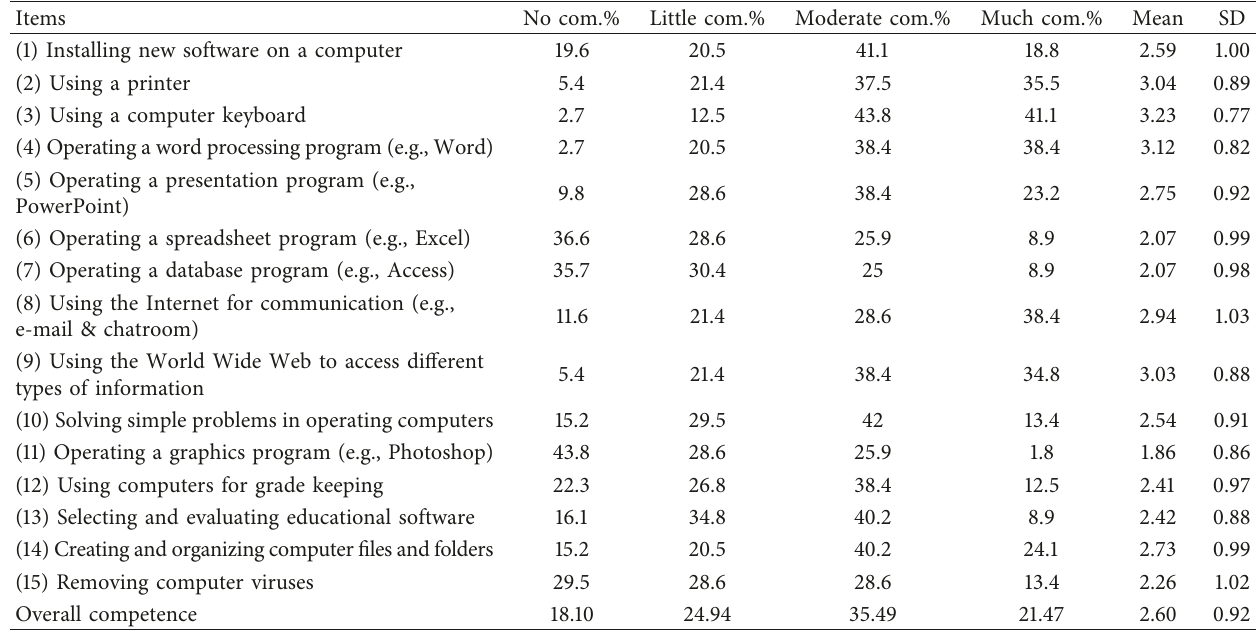
Table 4: Questionnaire results for EFL teachers’ perceived competency in integrating educational technology in their classes. Items No